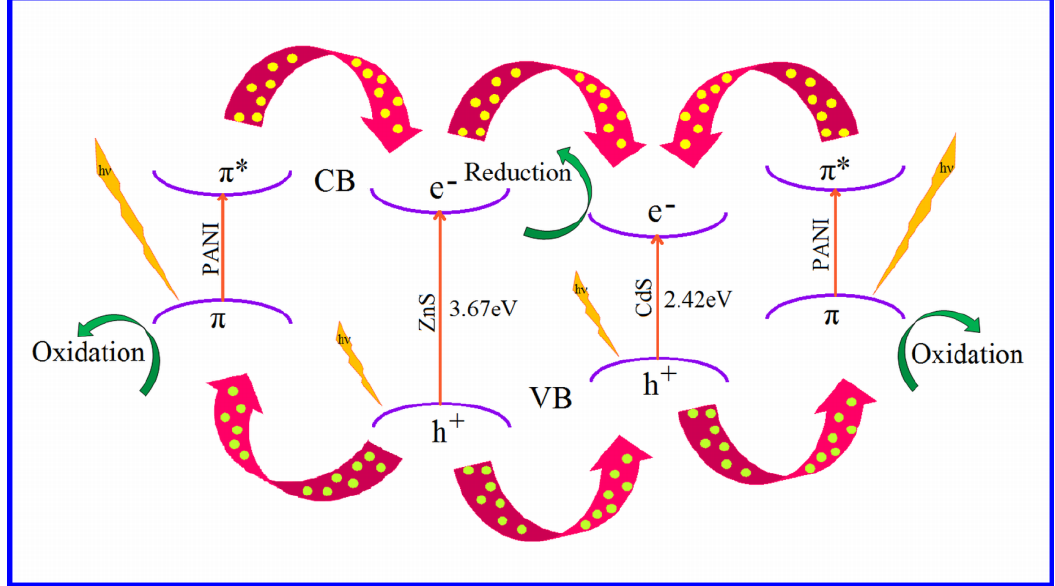
Figure 11. Representative diagram of the mechanism of photocatalysis by CZP.